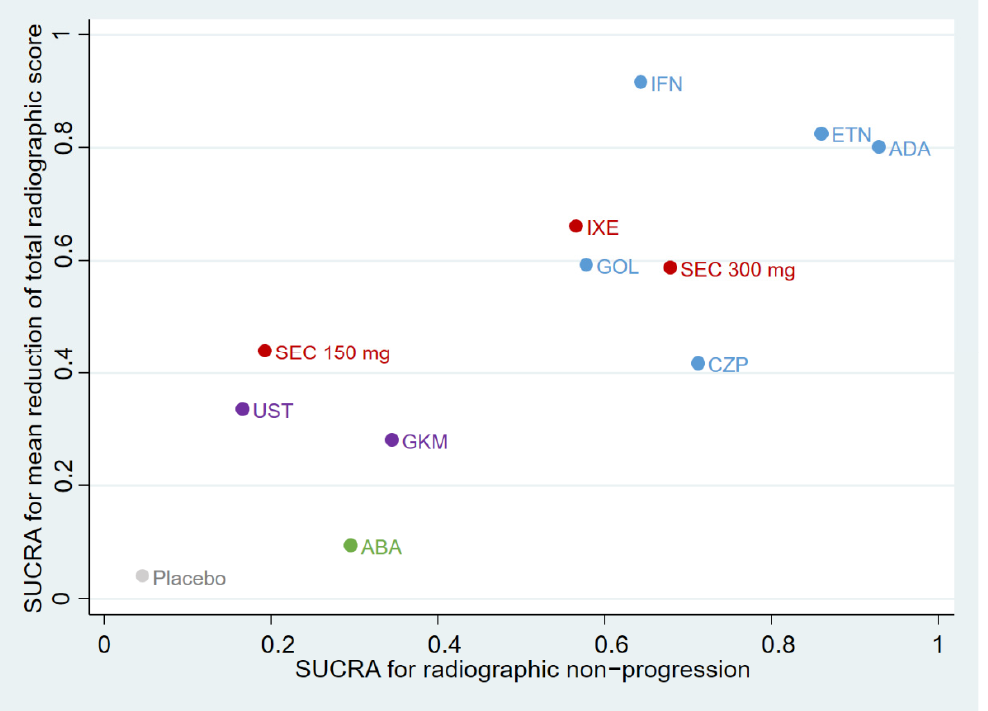
Figure 4. Ranking plot of different biological treatment for psoriasis arthritis patient network. Based on analysis of surface under the cumulative ranking curve (SUCRA) values for two different outcomes: non-progression and mean reduction in the total of radiographic score. Treatments in the upper right corner were associated with achieving both